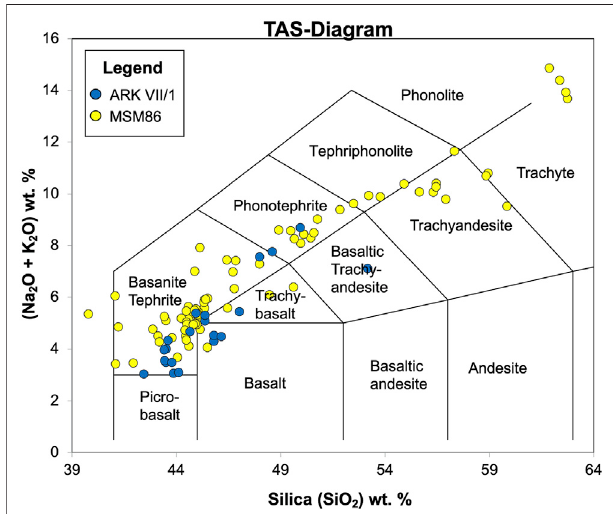
FIGURE 7 | Total Alkaline Silica-diagram; blue dots are the previously collected samples from expedition ARKVII/1 and yellow dots are the newly collected samples from expedition MSM86.